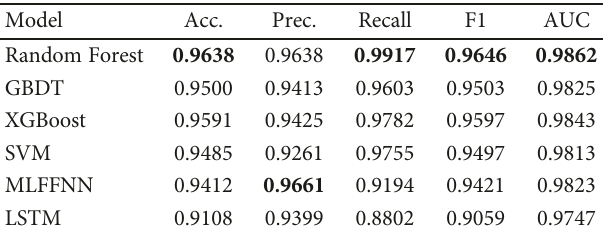
Table 6: Comparison of di ff erent models using all processed features on Twitter data.